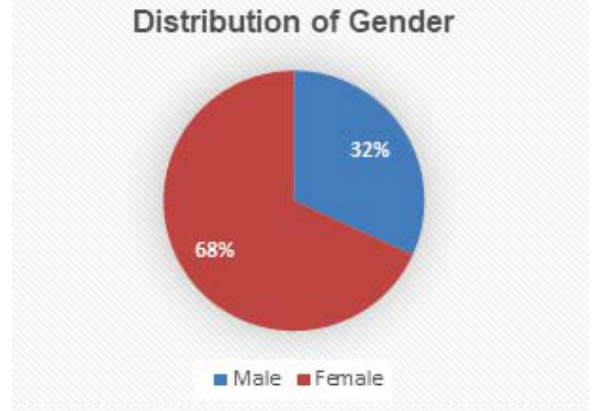
Table 2. Characteristics of cysts in the liver